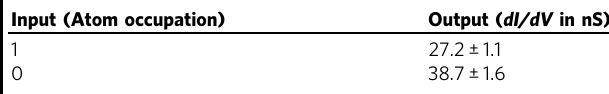
Table 1 The relation between the output and input for pseudo NOT gate.